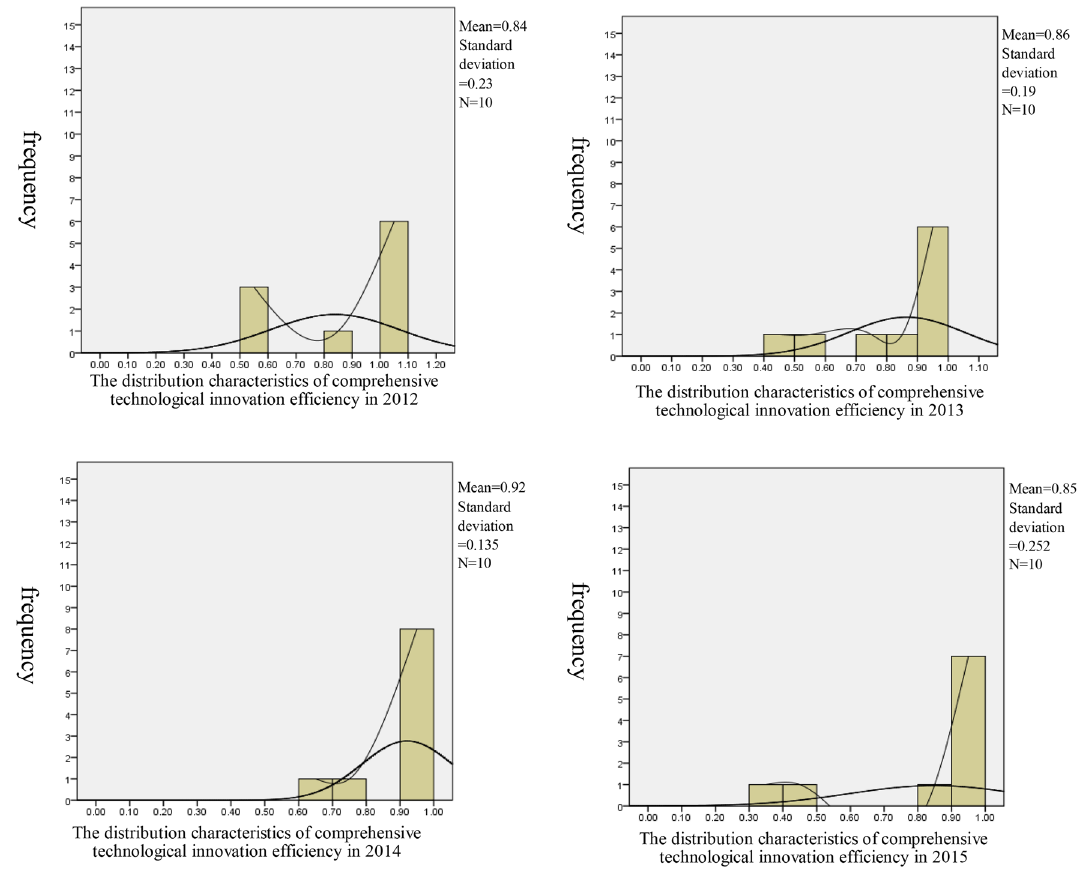
Fig. 2 Frequency of comprehensive technical innovation efficiency in